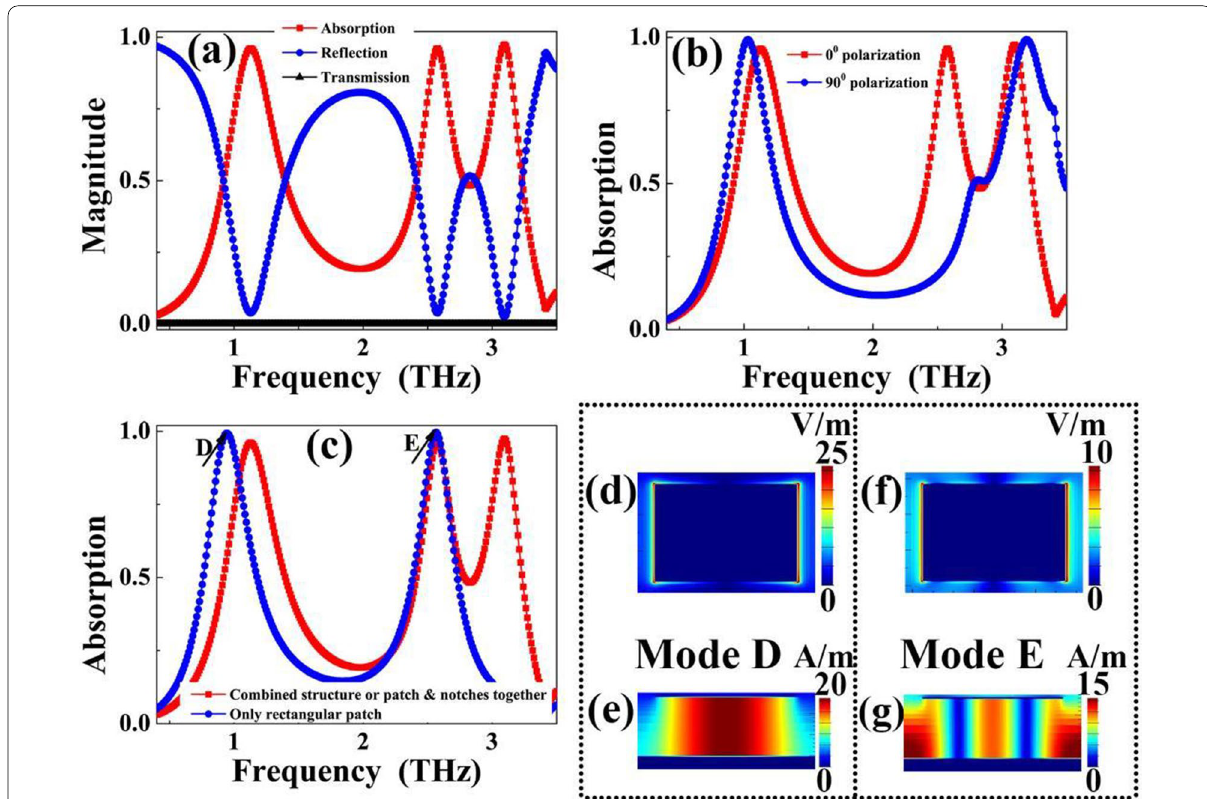
Fig. 2 a Absorption (red line), reflection (blue line) and transmission (black line) of the designed triple‑band MBLA; b simulated absorption spectra of designed device as a function of frequency under two orthogonal polarizations (0° means that the polarization is along the x axis, while 90° means that the polarization is along the y axis); c comparison of absorption properties of designed device (i.e., the combined structure or patch & notches together or analogy I‑typed resonator) and the rectangular patch absorber; d electric field | E | distribution of mode D for rectangular patch absorber with the blue line at c ; e magnetic field | Hy | distribution of mode D for rectangular patch absorber with the blue line at c ; f electric field | E | distribution of mode E for rectangular patch absorber with the blue line at c ; g magnetic field | Hy | distribution of mode E for rectangular patch absorber with the blue line at